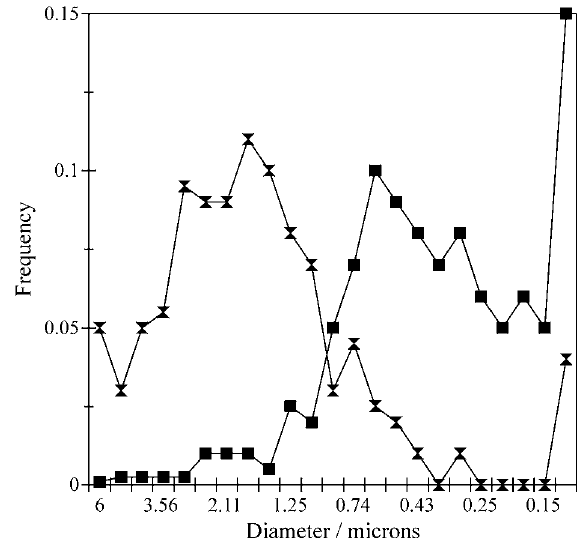
Figure 4. Frequency vs. Particle diameter curves for: • alumina and x zircon